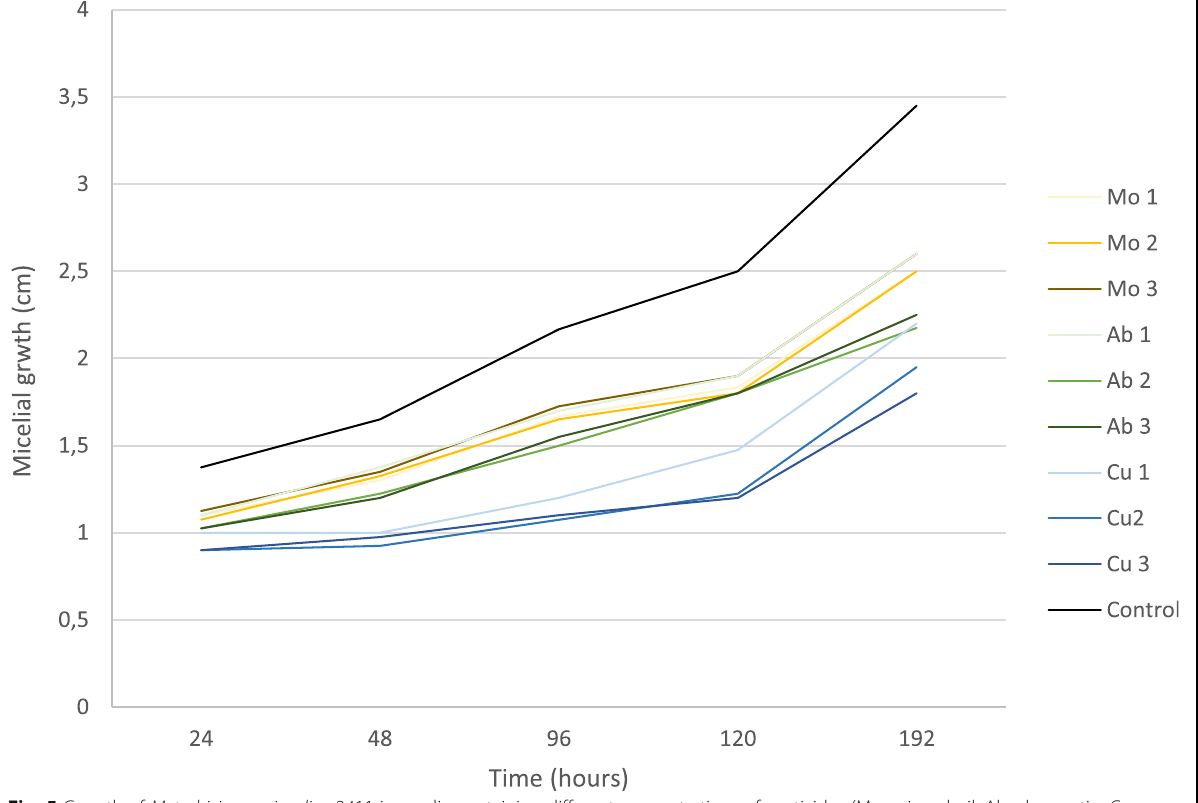
Fig. 5 Growth of Metarhizium anisopliae 2411 in media containing different concentrations of pesticides (Mo: mineral oil, Ab: abamectin,